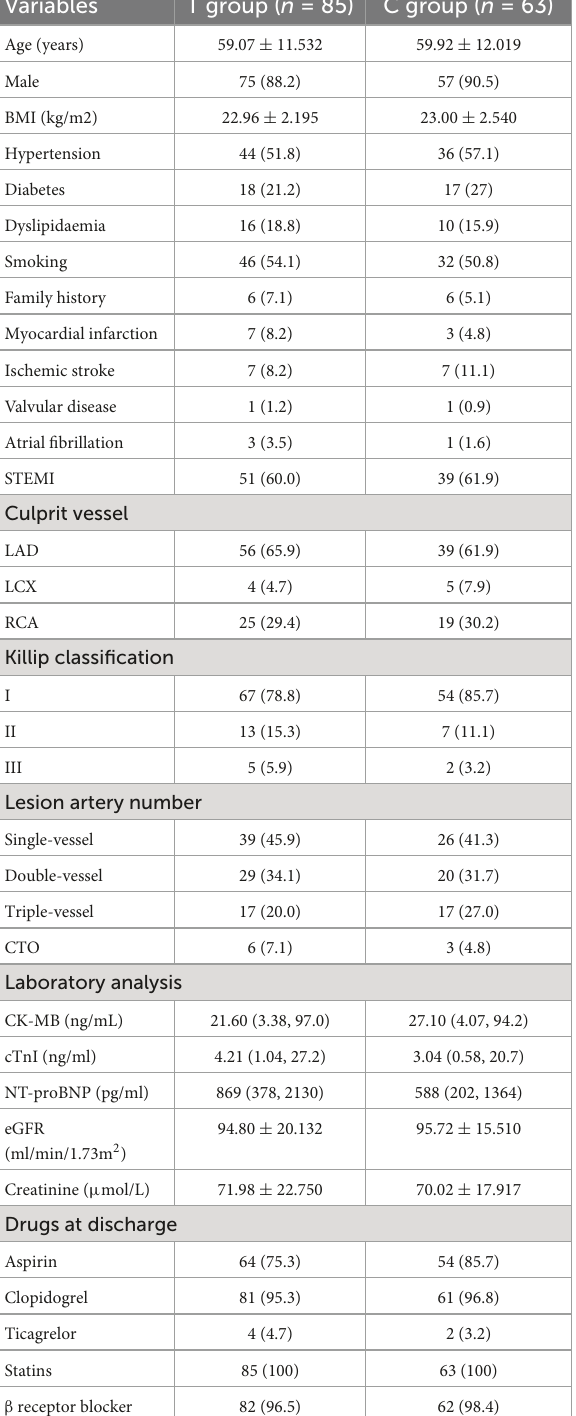
TABLE 1 The baseline characteristics of the